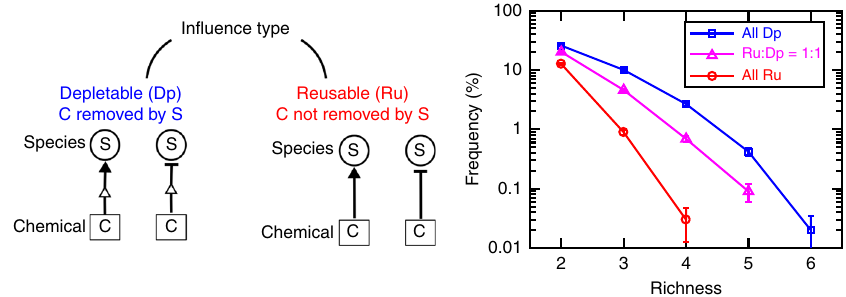
Fig. 6 Interaction mechanisms impact coexistence. To explore how different interaction mechanisms might in fl uence coexistence, we investigated two categories of chemical interactions: those with depletable mediators (Dp, recipients consume or degrade the chemical mediator) versus those with reusable mediators (Ru, recipients do not affect the mediator concentration). In the extreme cases, communities that used only Dp mediators showed remarkably higher coexistence compared to communities that used only Ru mediators. We also examined enrichment in communities with equal number of the two interaction types, and coexistence in these hybrid communities appeared to be in between the two extremes. In these simulations, links had a binomial network. The initial number of species types N c = 20, the number of possible mediators N m = 15, and the ratio of interaction types + : − = 50%:50%. Error bars indicate s.d. due to